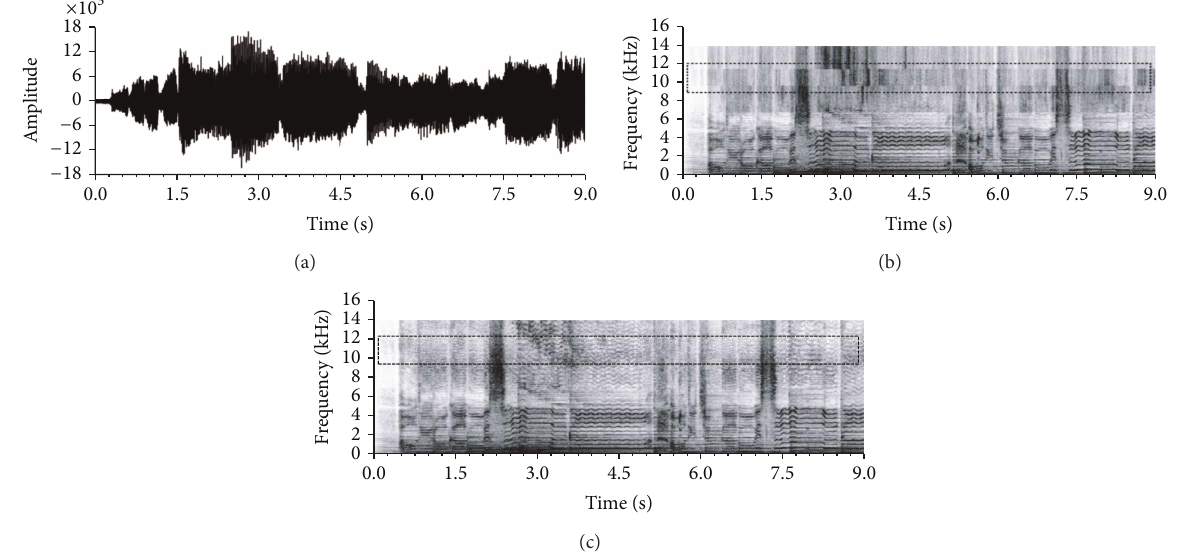
Figure 4: Comparison of spectrograms: (a) audio signal, (b) spectrogram of decoded signal by the conventional BWE algorithm, and (c) that by the proposed BWE algorithm.